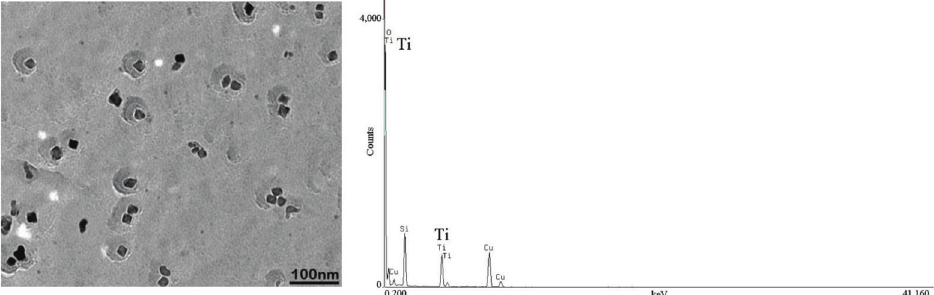
Figure 8: TiN in steel sample A quenched after solution treatment at 1,350°C for 5